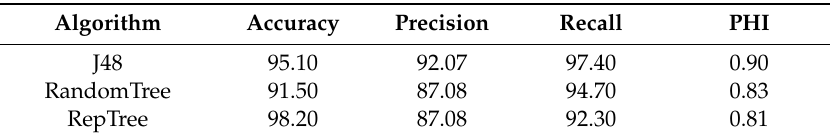
Table 5. Results for algorithms